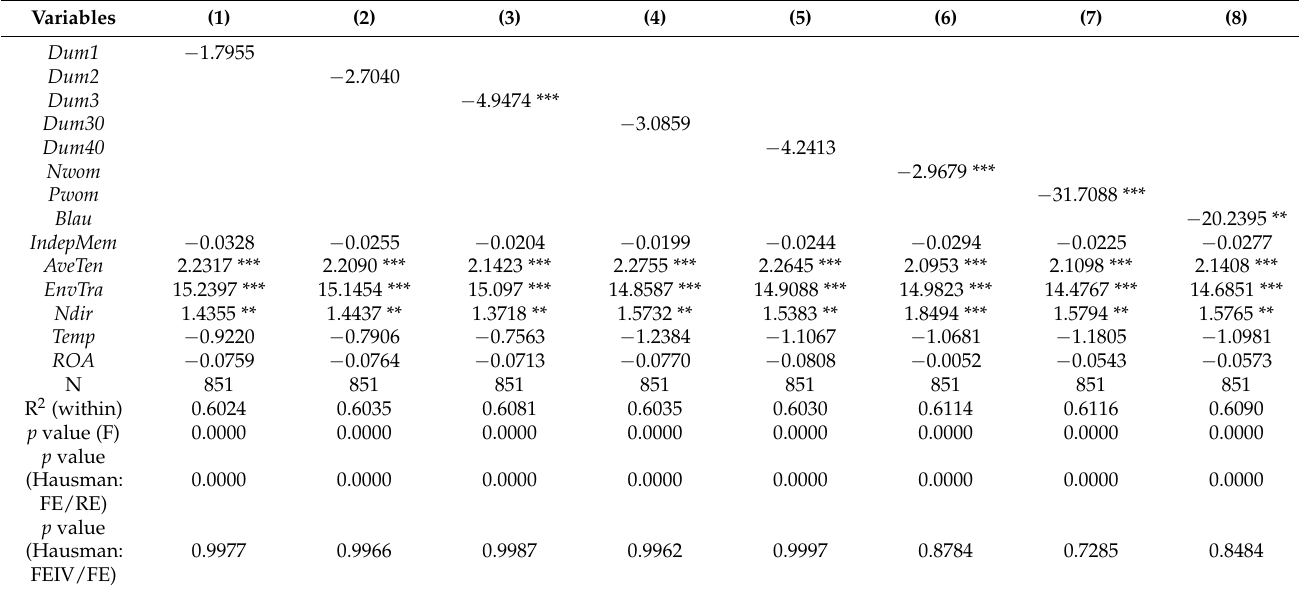
Table 7. Dependent variable: EnvSc . Fixed effects estimator (2002–2019).